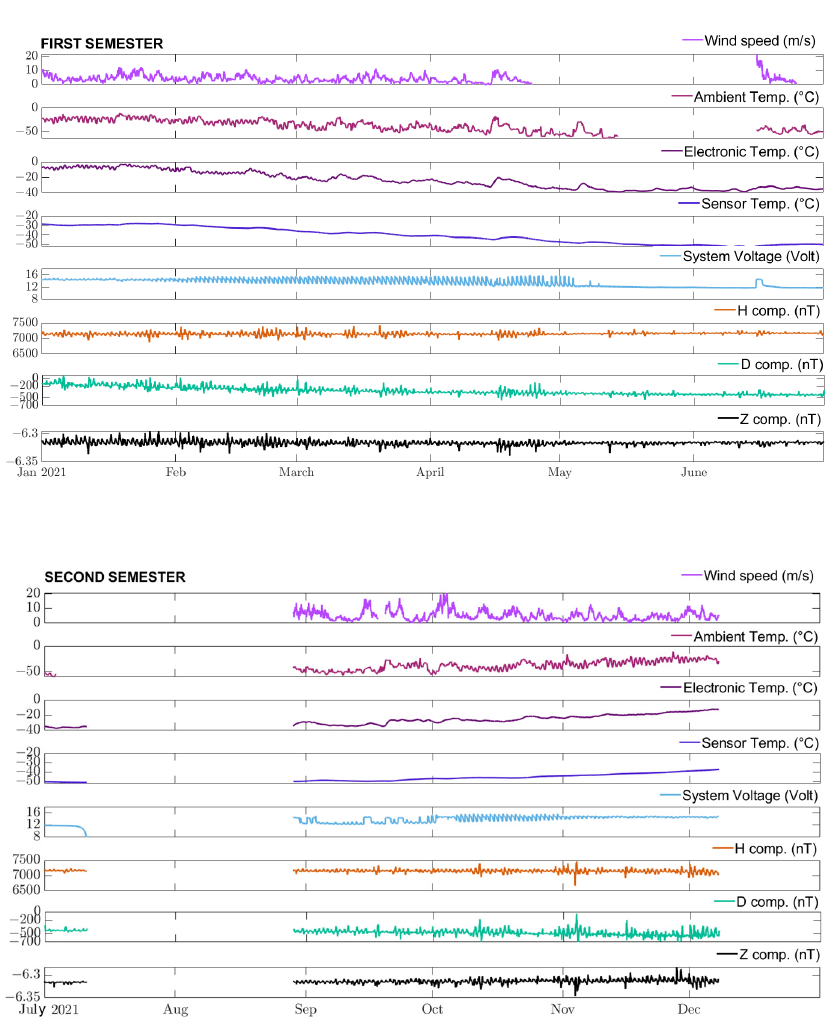
Figure 4. Plots for the first (upper panel) and the second semester of 2021 (lower panel) of the meteo- rological observed parameters, instrumental and geomagnetic dataset. From top to bottom: Wind speed (from Paola database), Ambient Temperature (from Paola database), Electronic Temperature, Sensor Temperature, System Voltage, H component, D component, Z component. The following gaps emerge: geomagnetic data gap from 11 July to 29 August; wind speed gap from 24 April to 15 June and from 24 June to 28 August; Temperature gap from 14 May to 15 June and from 3 July to 28